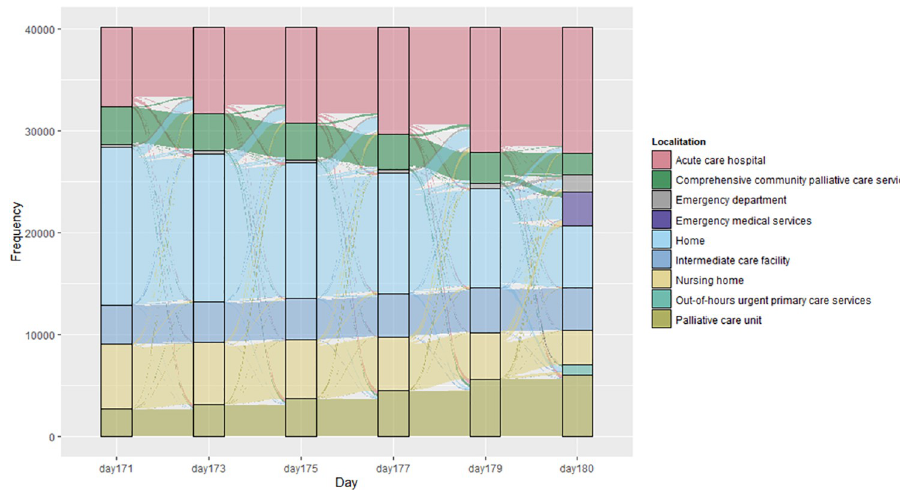
Fig 2. Transition of place of stay during the last 10 days before death. Vertical boxes show the place of stay at the given day, counting from 180 days before